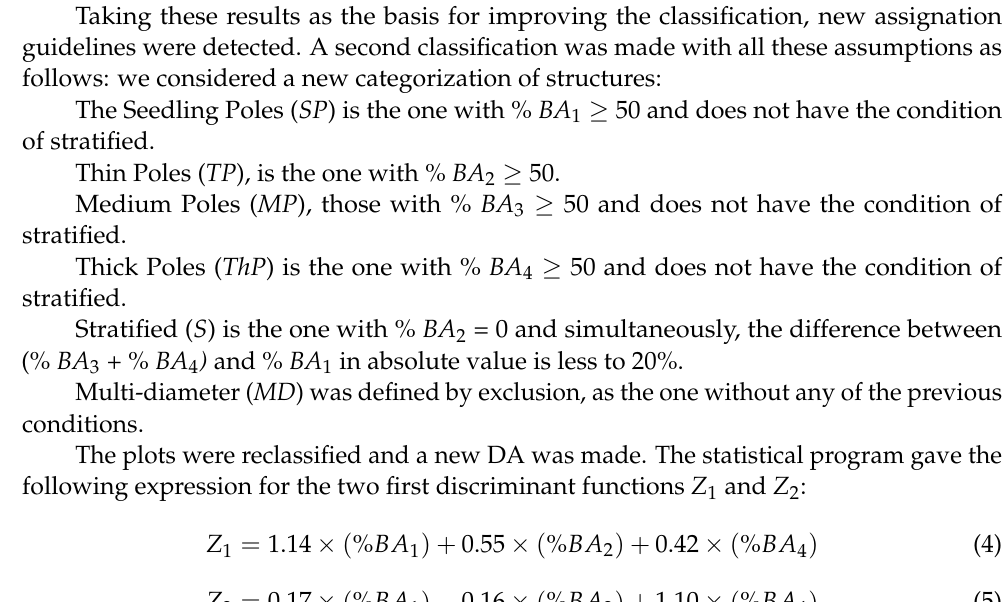
poles; TP : thin poles; MP : medium poles; ThP : thick poles; S : stratified; MD : multi-diameter).